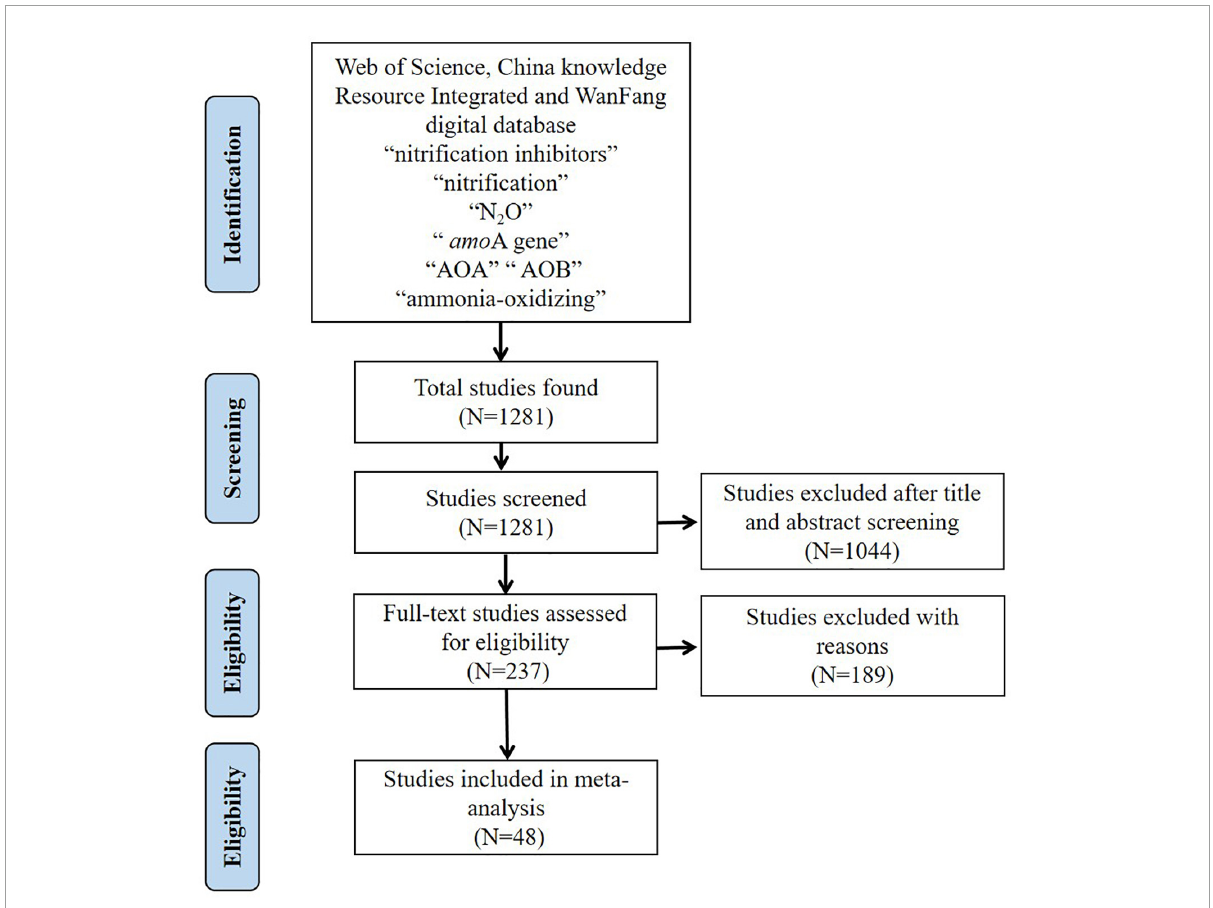
FIGURE1 Selection of studies for inclusion in the